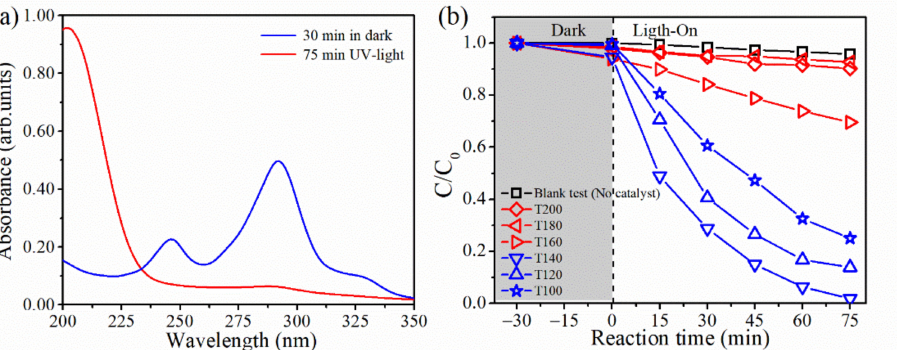
Figure 8. ( a ) UV spectrum (200–350 nm) for a dispersion containing the T140 sample in dark (blue line) and after 75 min of UV irradiation (red line). ( b ) Time dependence of the relative concentration changes of MB and UV irradiation time of all samples.